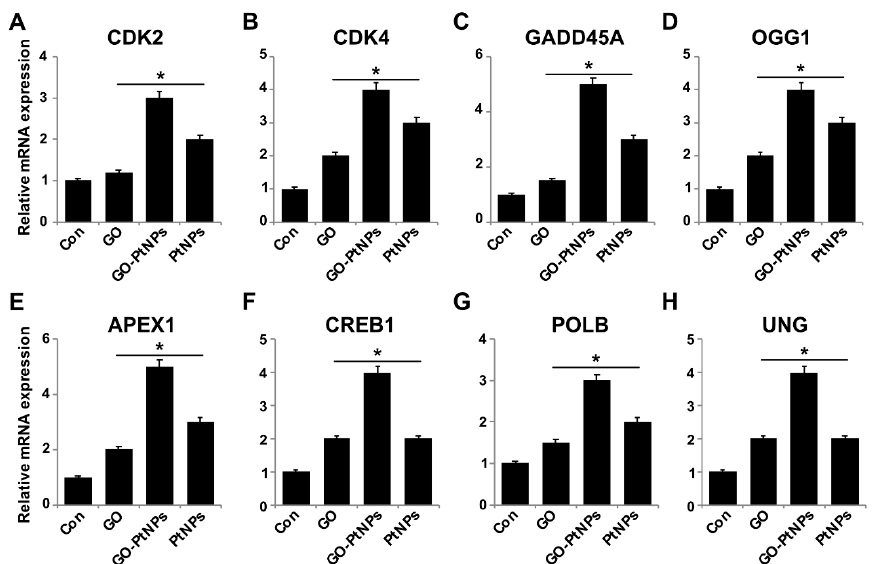
Figure 14. E ff ect of GO, GO-PtNPs, and PtNPs on expression cell cycle arrest and DNA damage genes. LNCaP cells were treated with respective IC50 concentrations of GO, GO-PtNPs, and PtNPs for 24 h. Relative messenger RNA(mRNA) expression of CDK2 ( A ), CDK4 ( B ), GADD45A ( C ), OGG1 ( D ) APEX1 ( E ), CREB1 ( F ), POLB ( G ), and UNG ( H ) was analyzed by quantitative reverse-transcription polymerase chain reaction in LNCaP cells treated for 24 h. After 24-h treatment, expression fold level was determined as fold changes in reference to expression values against GAPDH. Results are expressed as fold changes. There was a significant difference in treated cells compared to untreated cells with Student’s t -test (* p < 0.05).